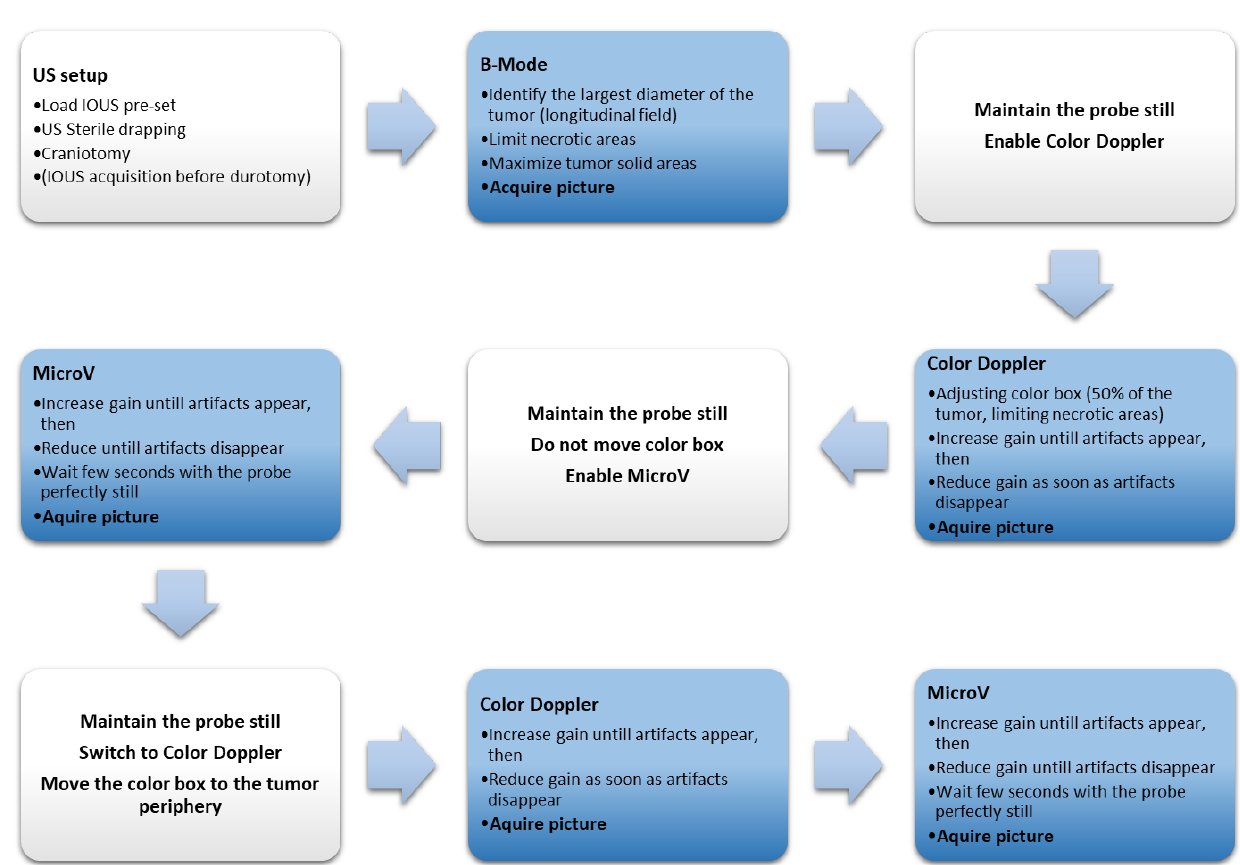
Figure 1. Step by step flowchart of the standardized protocol of IOUS image acquisition.